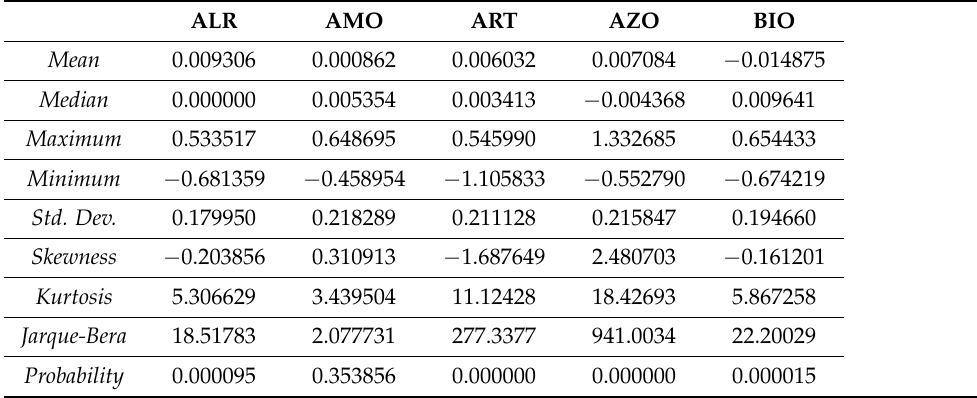
Table A1. Descriptive statistics for individual companies listed at Bucharest Stock Exchange (monthly returns for January 2004–April